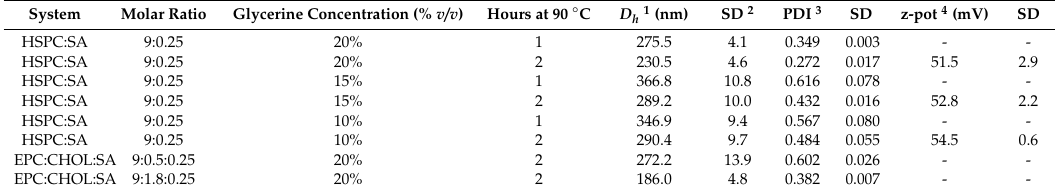
Table 1. The physicochemical properties of lipidic vehicles developed through the MHM. System